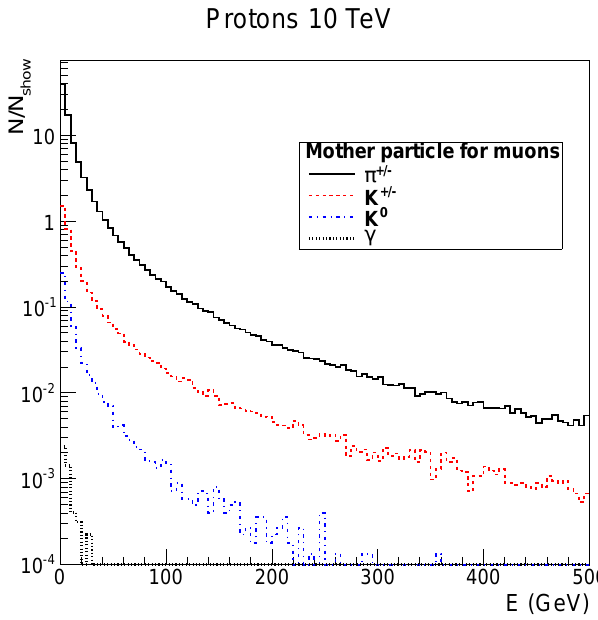
Fig. 1. Energy distributions, at an altitude of 870 m, of the muons ( E µ > 1 GeV) from showers initiated by 10TeV vertical protons, as simulated in GEANT4. The contributions from the different mother particles are dissociated: pions (solid line), charged kaons (dashes), neutral kaons (dot dashes), gammas (dots). The vertical axis indi- cates the mean number of particles per